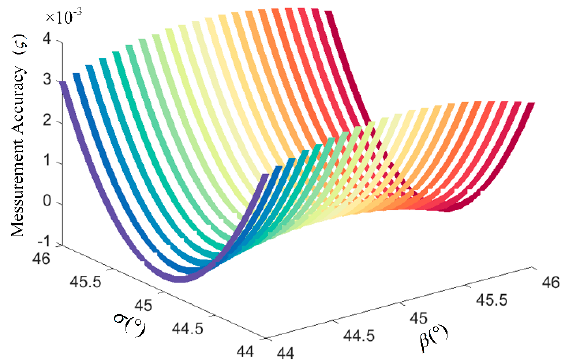
Figure 5. The influence of β and σ on the measurement accuracy of closed-loop OVSs.